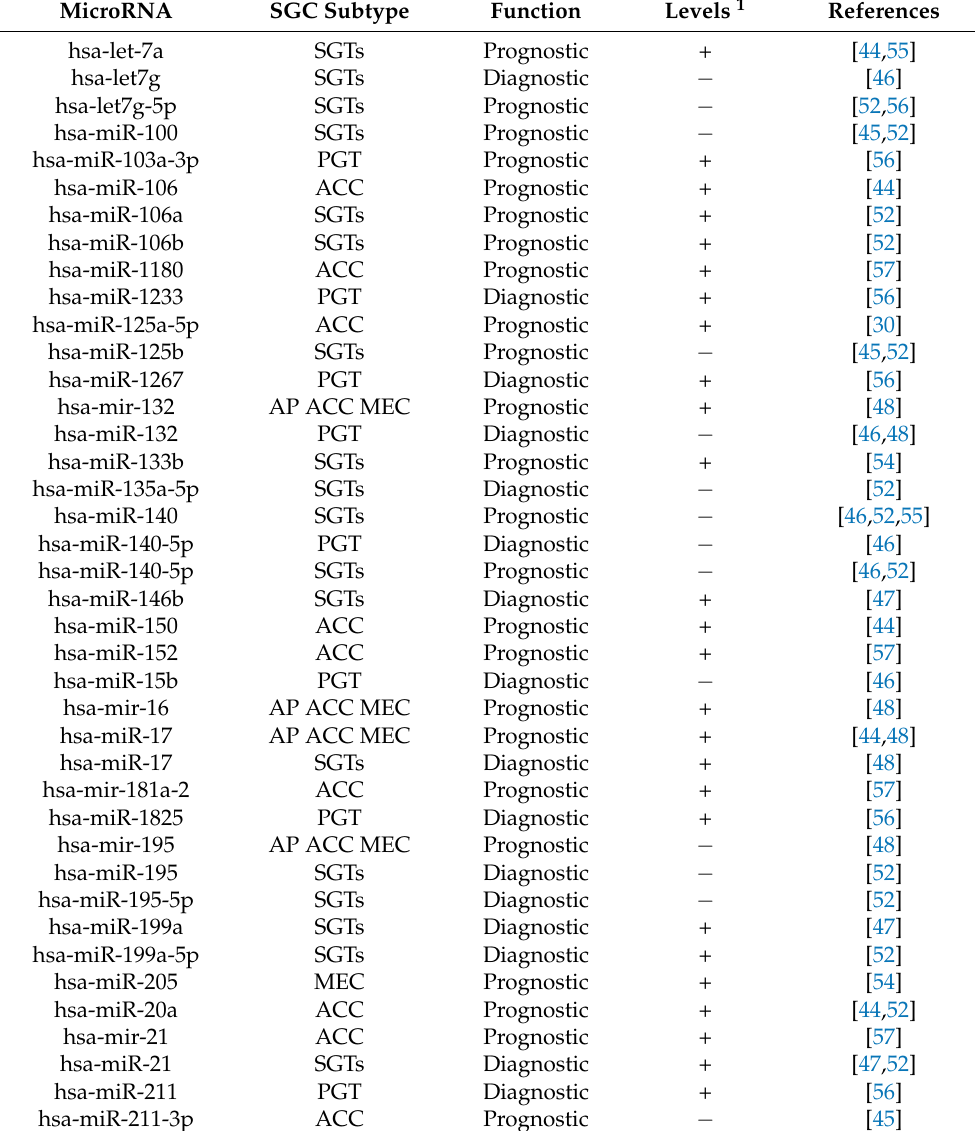
Table 2. MicroRNA modulation and function in